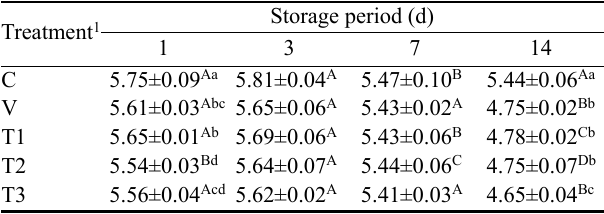
Table 2. Changes in pH of fresh pork patties mixed with Viscum album L. (VAL) extract